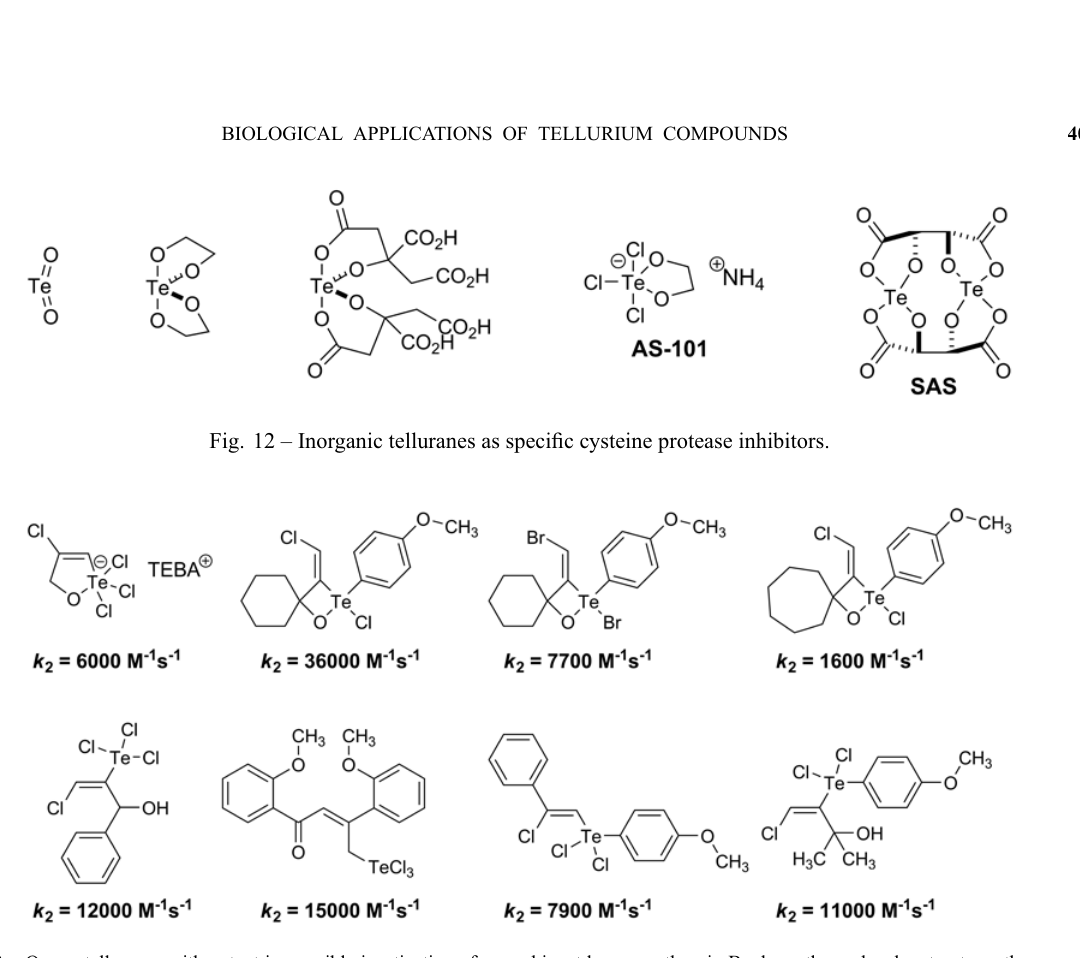
Fig. 13 – Organotelluranes with potent irreversible inactivation of recombinant human cathepsin B, above the molecular structures the second- order inactivation rate constants determined for each compound is